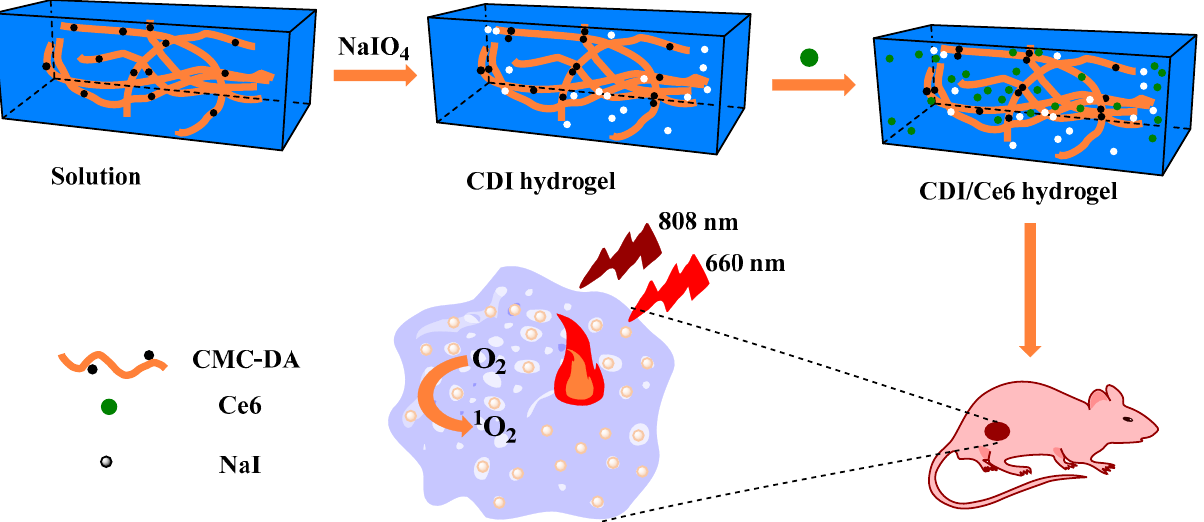
Figure 3. Schematic illustration of the preparation of CDI/Ce6 hydrogel for photothermal and photodynamic anti-tumor recurrence [48]. Copyright 2021 Elsevier Ltd.